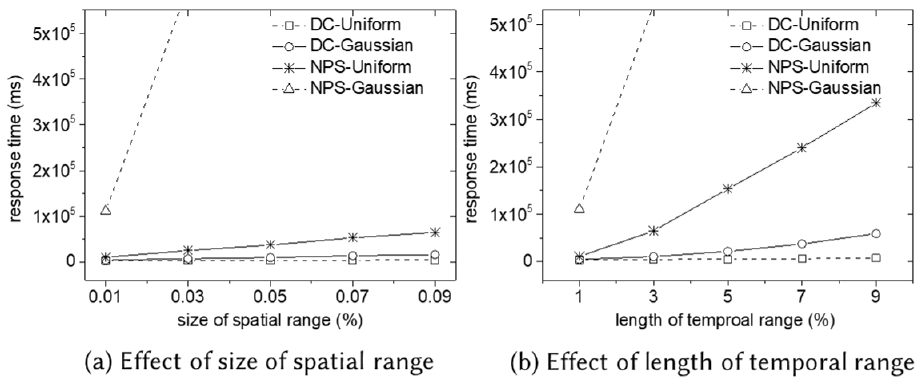
Figure 12. Effect of query cuboid size in 3D MaxRS.